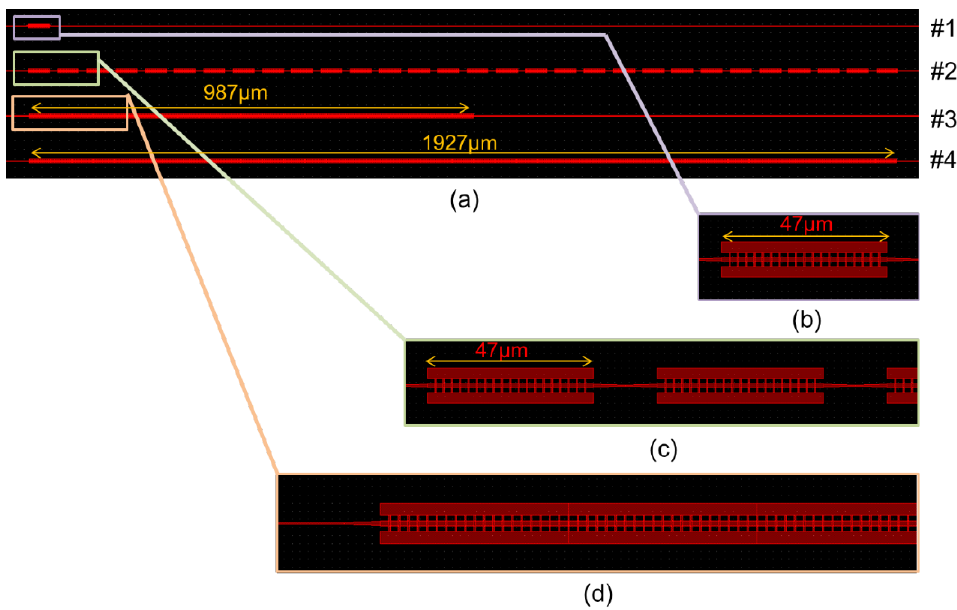
Figure 5. ( a ) Four types of MMI waveguides with fins for measuring propagation loss, and magnified drawing of ( b ) waveguide #1, ( c ) waveguide #2, and ( d ) waveguide #3.